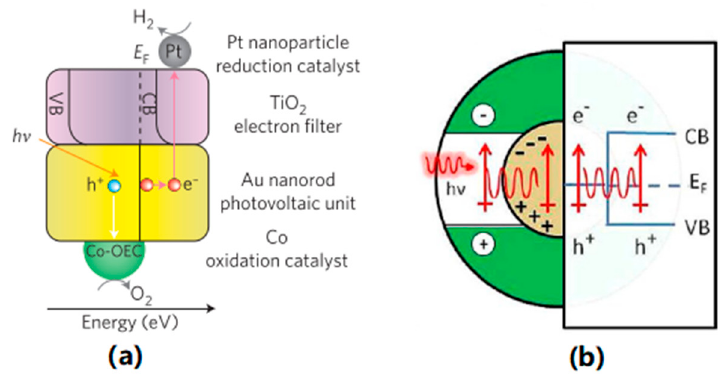
Figure 4. ( a ) Schematic diagram of a hot-electron induced photosynthesis device with Pt reduction